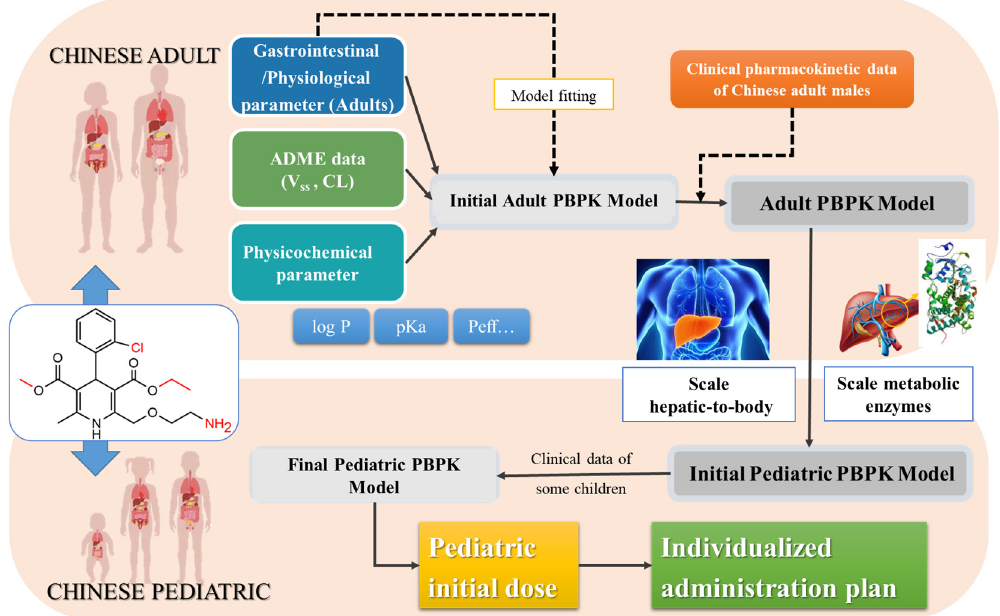
Figure 1. Workflow for the development of the PBPK model to predict dosages.